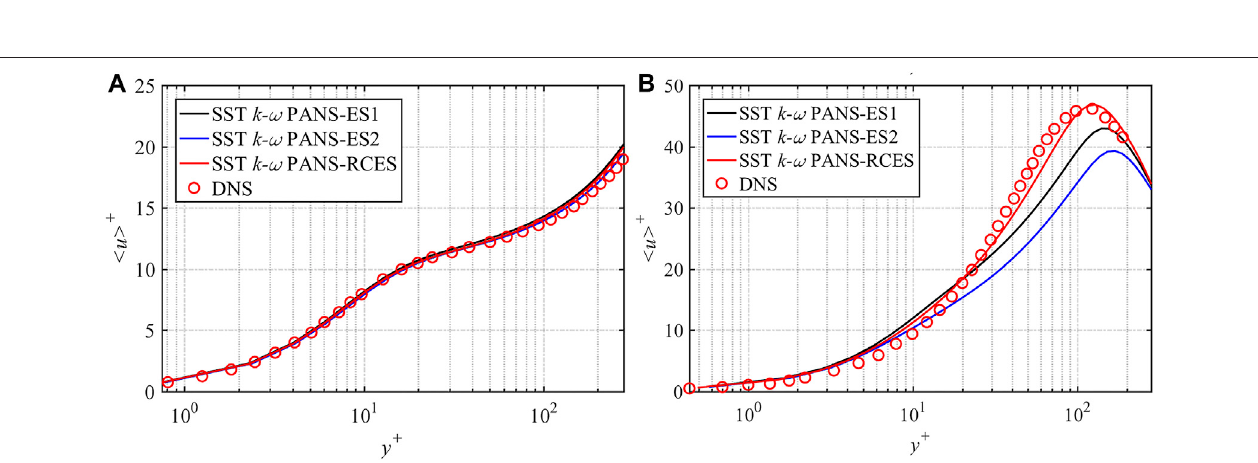
FIGURE 6 | Comparison of mean streamwise velocity distribution in the near-wall area at Ro = 0.6: (A) pressure side and (B) suction side.